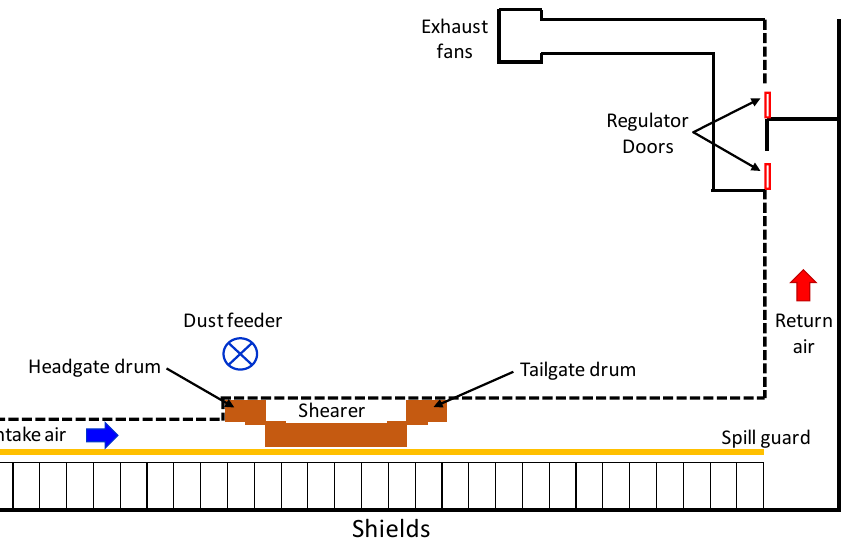
Figure 3. A plan view of the Pittsburgh Research Laboratory (PRL) longwall test gallery (not to scale).